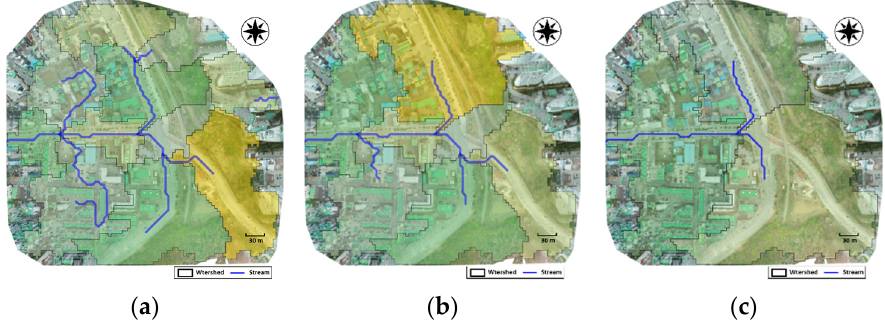
Figure 12. Watershed analysis thresholds: ( a ) 300; ( b ) 700; ( c ) 1100.